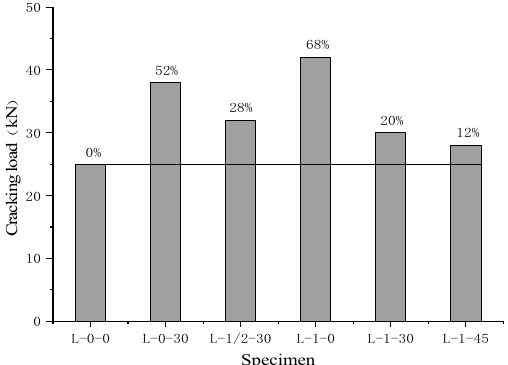
Figure 6. Comparison of the cracking load of each specimen.